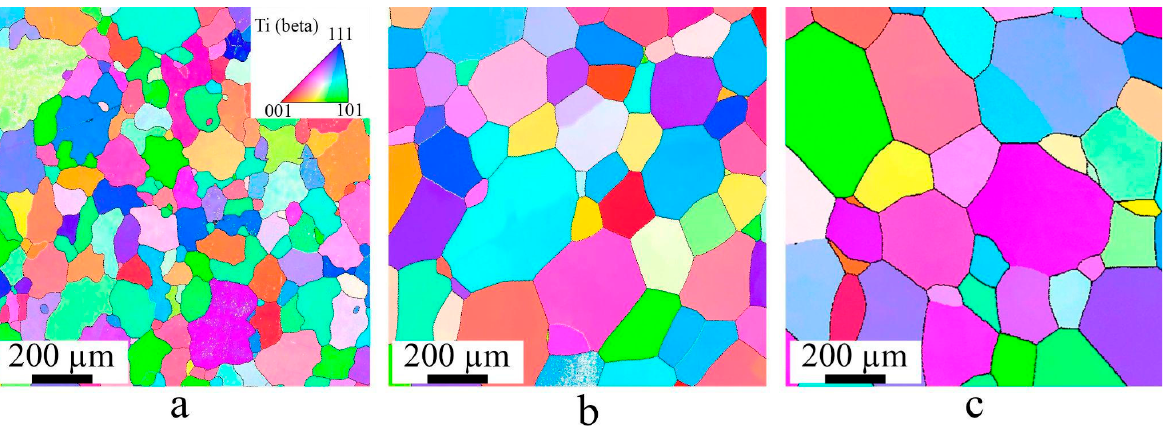
Figure 1. IPF maps of the initial microstructure of Ti30Nb20 ( a ), Ti40Nb10 ( b ), and Ti50Nb0 ( c )